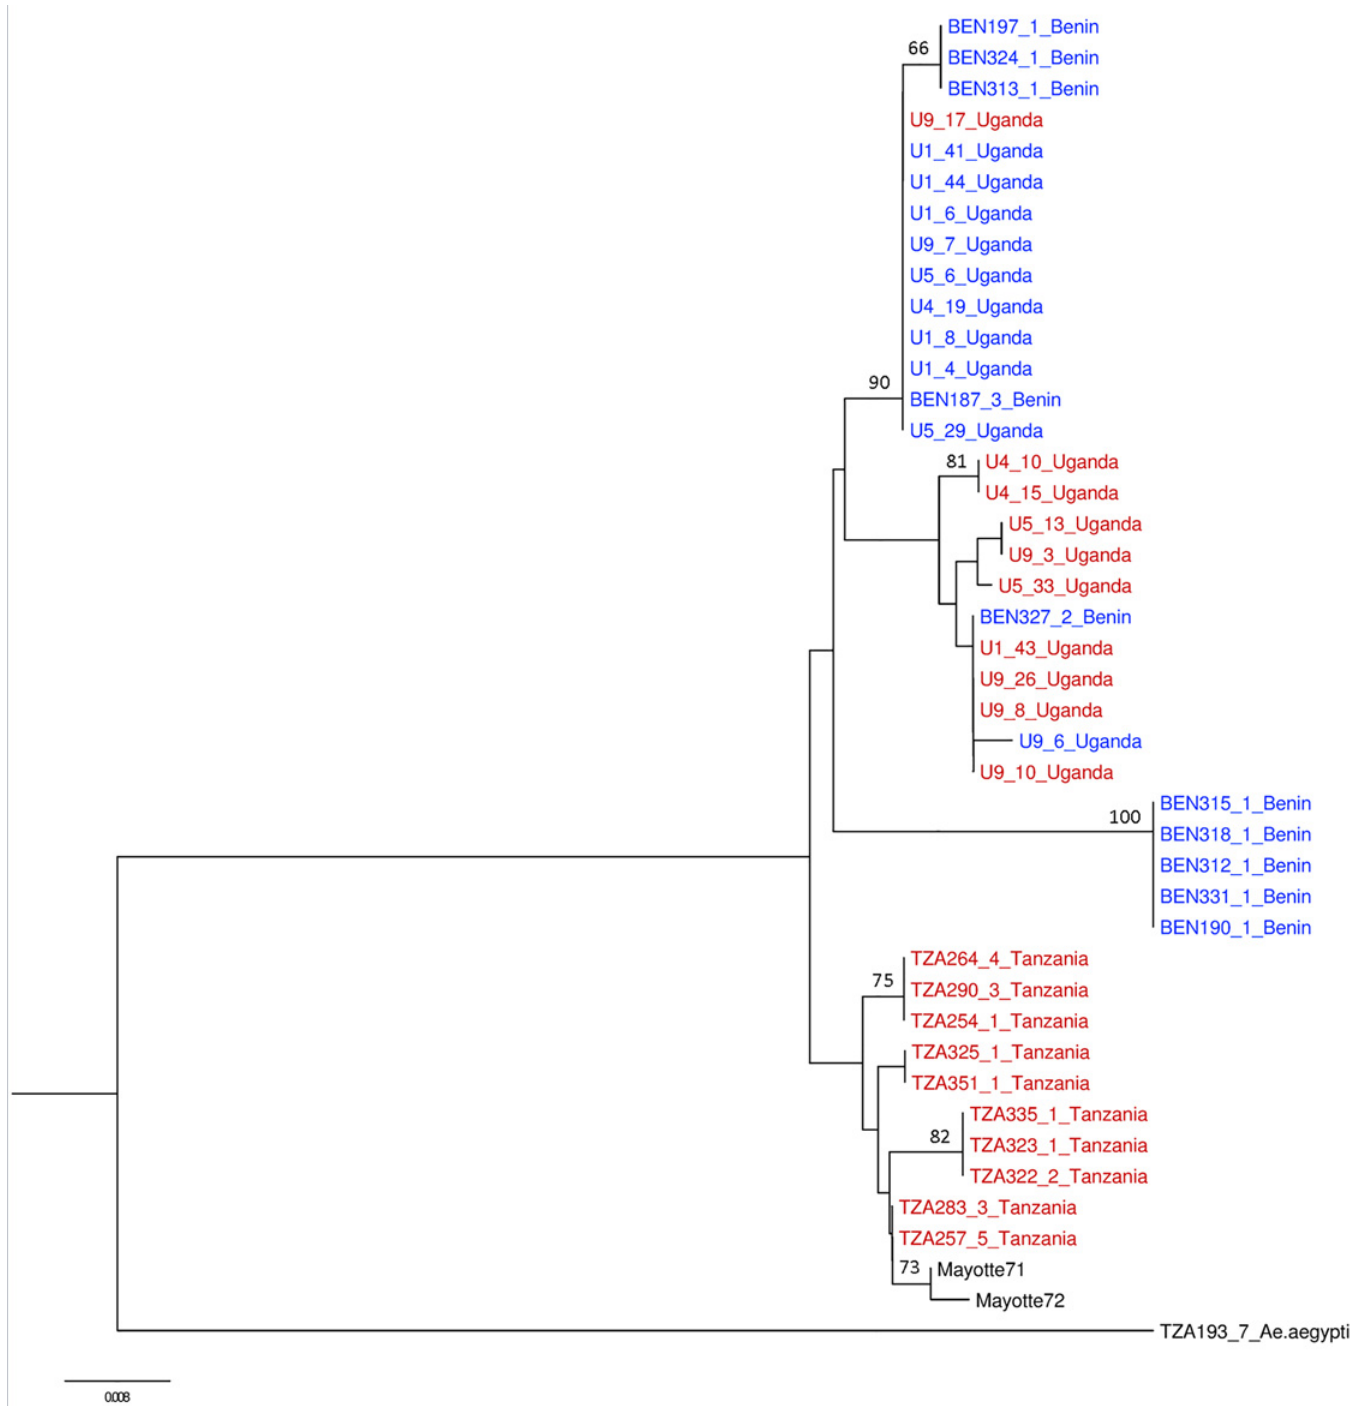
Fig 5. Neighbour joining tree of COI sequence data with labels coloured according to ITS -based species designation. Red labels represent Ae . bromeliae while blue labels are Ae . lilii . Sequences from Le Goff et al . [43] (^) are annotated. Bootstrap support values for branches above 55% are shown.